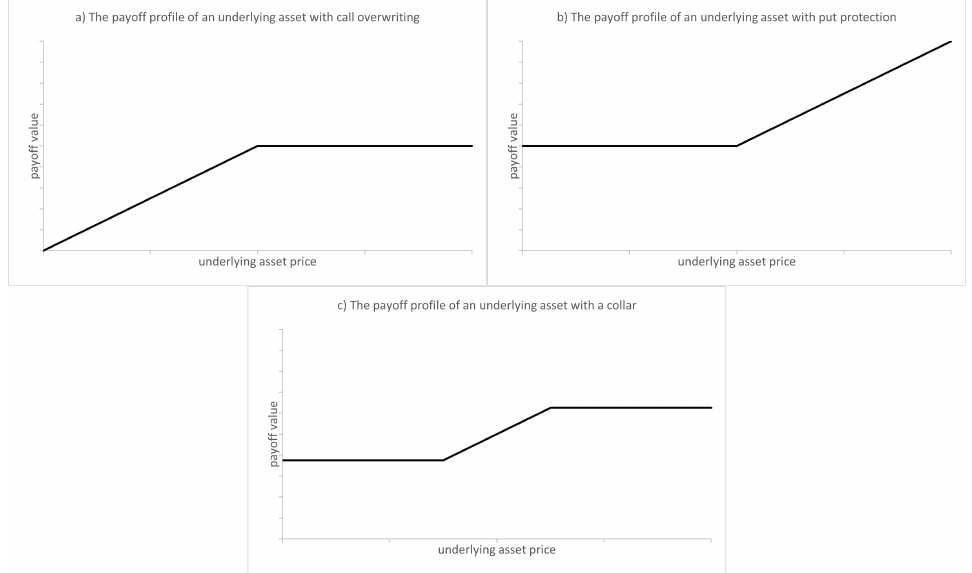
Figure 2. The payoff profiles of underlying asset overlaid with: ( a ) a call overwriting strategy in the first panel; ( b ) a put protection strategy in the second panel; and ( c ) a collar strategy in the third